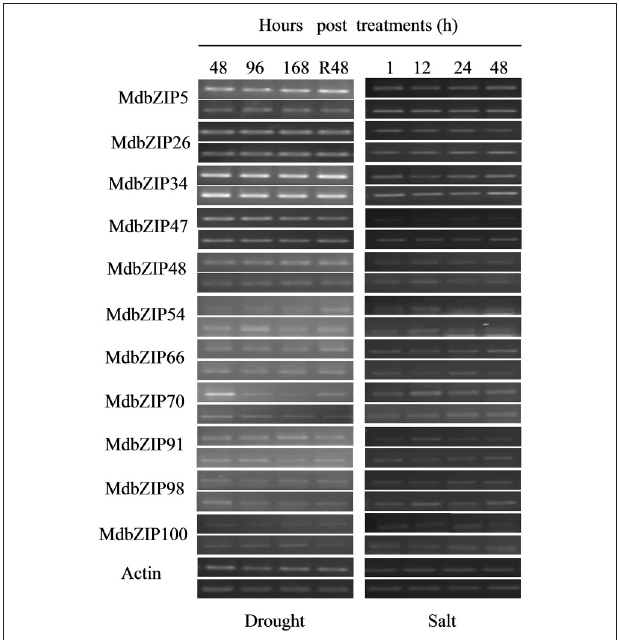
FIGURE 9 | Expression patterns of apple bZIP genes from group A following abiotic stress treatments (drought and saline conditions). Expression patterns of MdbZIP genes following drought and salt treatment were determined by semi-quantitative RT-PCR analyses. For each gene, the upper band represent amplified products from the treated leaves, band under them represent amplified products from untreated leaves. The apple EF-1a gene was used as the reference gene. Hours (1, 12, 24, 48) post-treatments are indicated in the